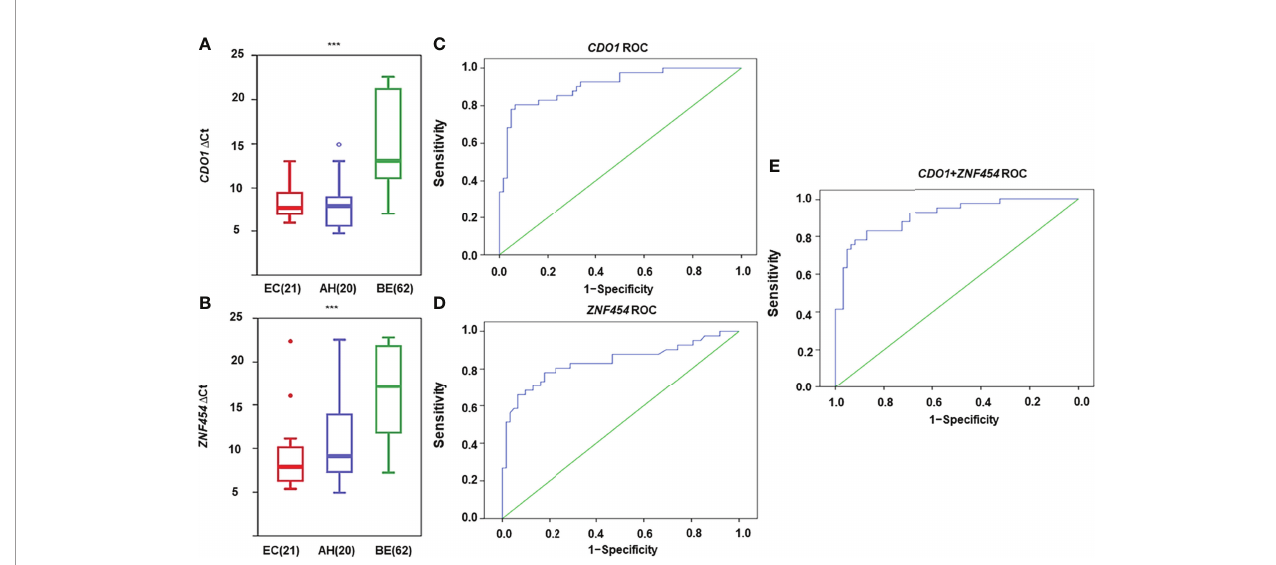
FIGURE 3 | DNA methylation levels for candidate genes detected by quantitative methylation-speci fi c polymerase chain reaction (qMSP) in histological specimens. DNA methylation levels are displayed as the difference in cycle threshold ( D Ct) – values for (A) CDO1 and (B) ZNF454 . Horizontal bars in the middle indicate the average methylation levels. The area under the receiver operating characteristic curve (AUC-ROC) for the DNA methylation status of (C) CDO1 , (D) ZNF454 , and (E) combination of the two genes. *** P < 0.001.